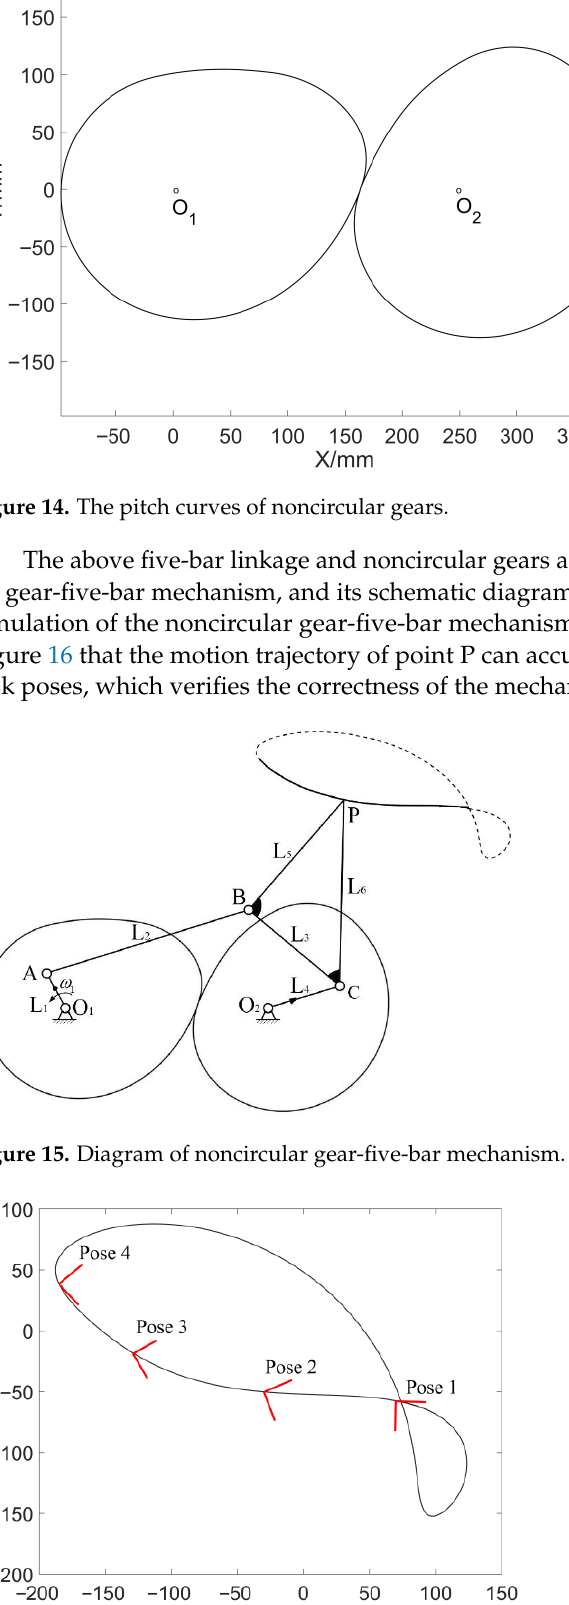
Figure 13. The ratio curve of noncircular gears.